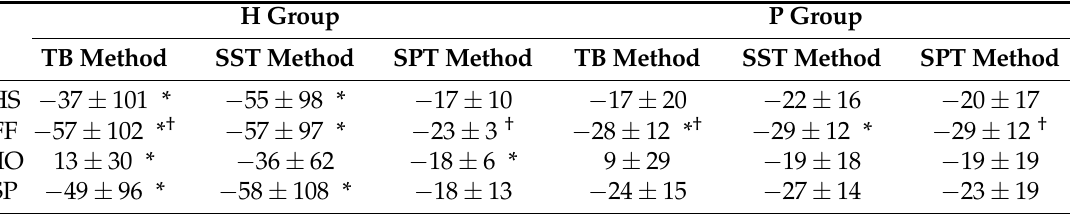
Table 3. Timing errors of the detected gait phases (mean ± std) [ms]. These data were generated by comparing the estimates provided by each classifier with the reference data. Asterisks * and obelisks † indicate significant differences between marked algorithms (Bonferroni, p <